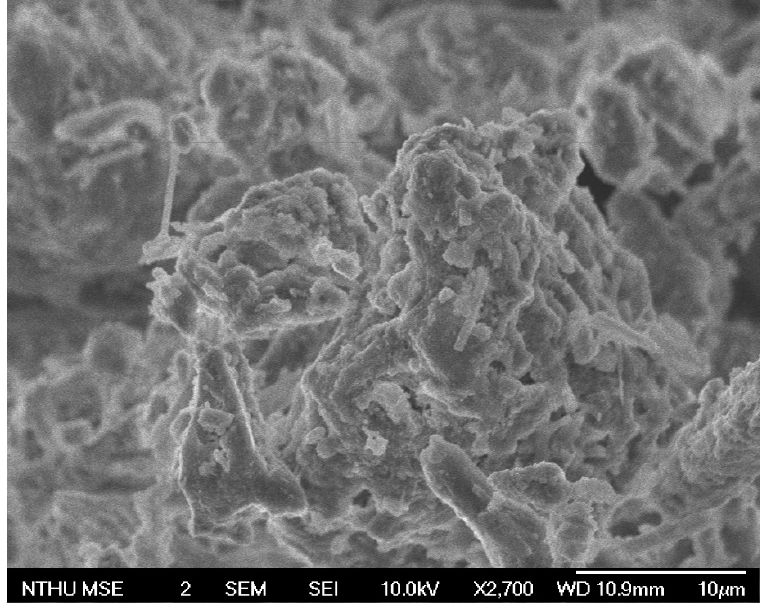
Figure 8. SEM of paste with ladle slag.